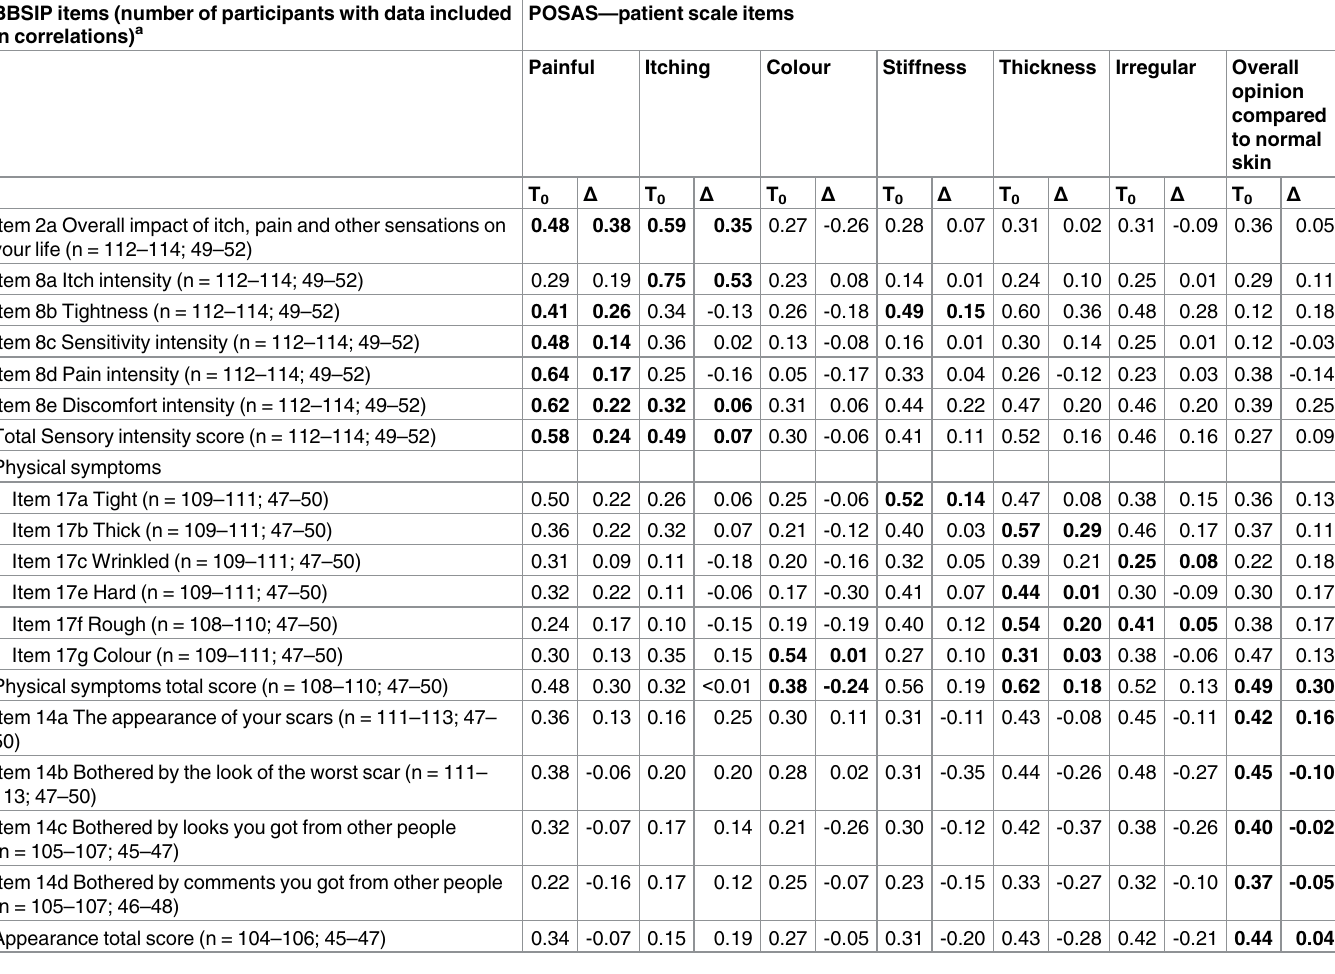
Table 2. Correlations between BBSIP items and POSAS patient scale items at baseline and from baseline to 1-month follow-up corresponding to hypotheses. BBSIP items (number of participants with data included in correlations) a